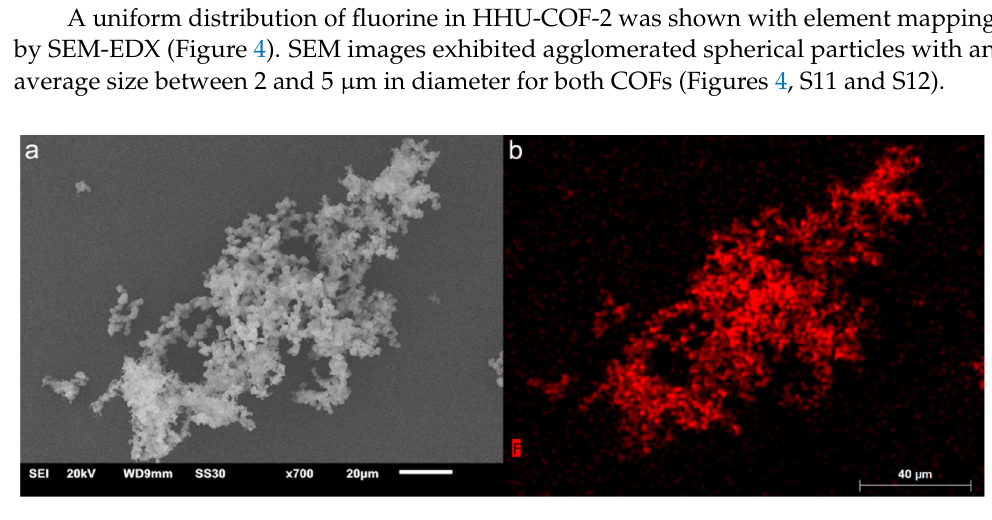
Figure 4. ( a ) SEM image of HHU-COF-2 and ( b ) associated fluorine elemental mapping.